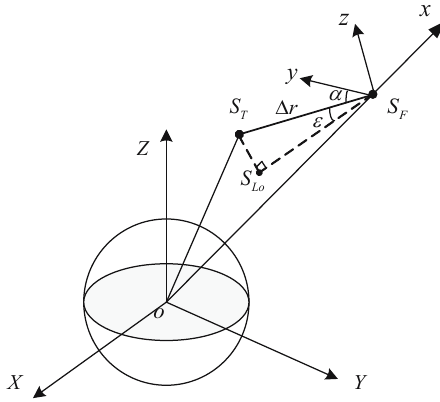
Figure 1: Relationship between the line - of - sight angles in a relative motion